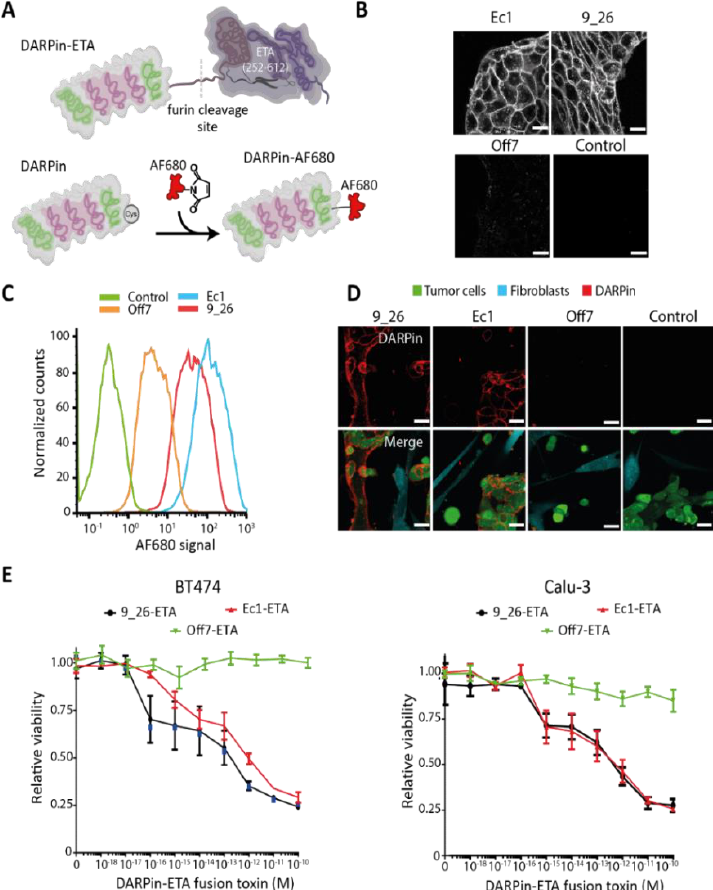
Figure 2. Binding and specificity of DARPins targeting EpCAM or HER2 on different cancer cells. ( A ) Schematic representation of a DARPin fused to the translocation and catalytic domains of Pseudomonas aeruginosa exotoxin A (ETA; aa 252–612) and of a DARPin coupled to Alexa Fluor 680. ( B ) Confocal microscopy images of an Alexa Fluor-680-labeled EpCAM-binding DARPin (Ec1) and a HER2-binding DARPin (9_26) bound to live Calu-3 cells. Off7 was included as a non-binding control. Scale bars: 40 µ m. ( C ) Representative flow cytometry histogram showing the binding of Alexa Fluor (AF) 680-labeled DARPins to Calu-3 cells, n = 2. ( D ) Specificity of DARPins towards Calu-3 cells in co-cultures with IMR-90 fibroblasts. Scale bars: 40 µ m. ( E ) Toxicity in 2D of BT-474 and Calu-3 cells of DARPin-ETA fusion proteins after 48 h of incubation as evaluated by a resazurin